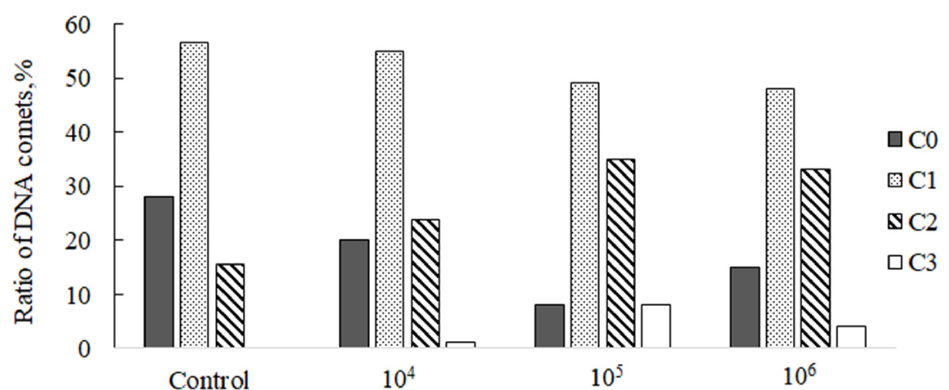
Figure 2. Induction of DNA strand breaks, represented as a percentage of comet damage classes in spermatozoa from control and experimental groups (N = 16; n = 800).